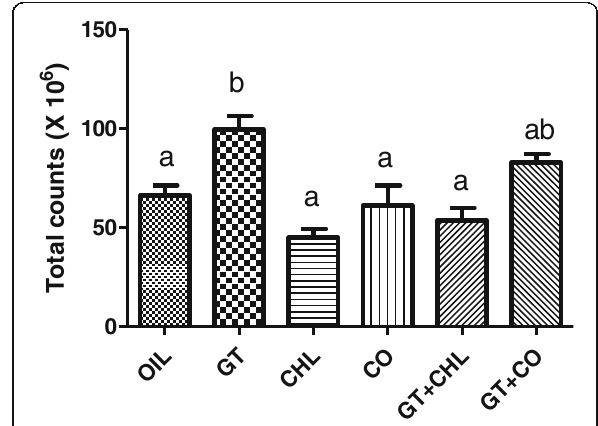
Fig. 1 Total sperm count (× 10 6 ) in Wistar rats treated with mineral oil (OIL), green tea (GT), chlorpyrifos (CHL), extract of clove oil (CO), green tea and chlorpyrifos (GT+CHL), and green tea and extract of clove oil